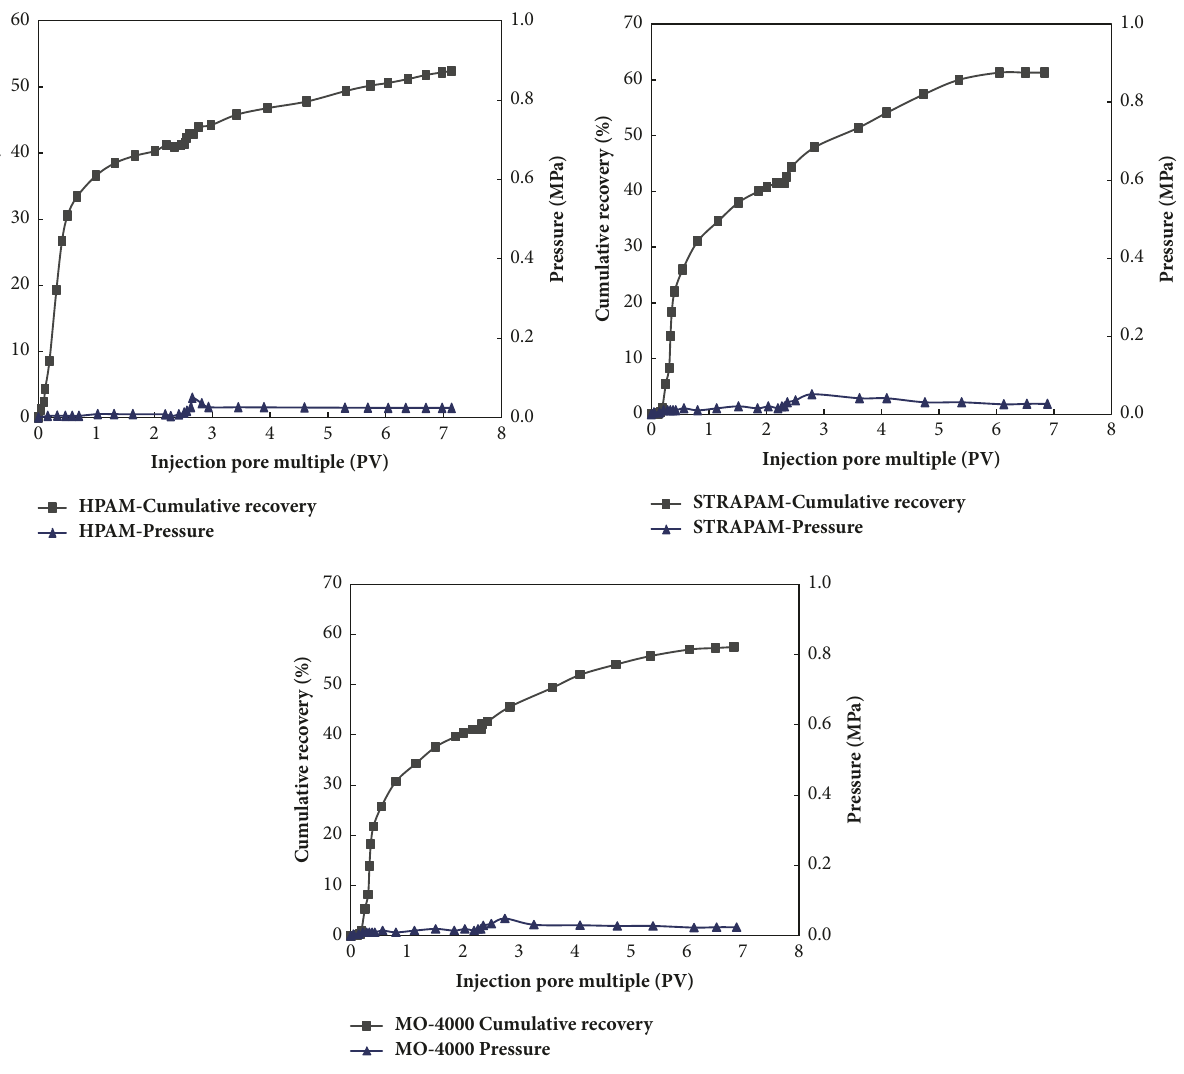
Figure 11: Polymer flooding